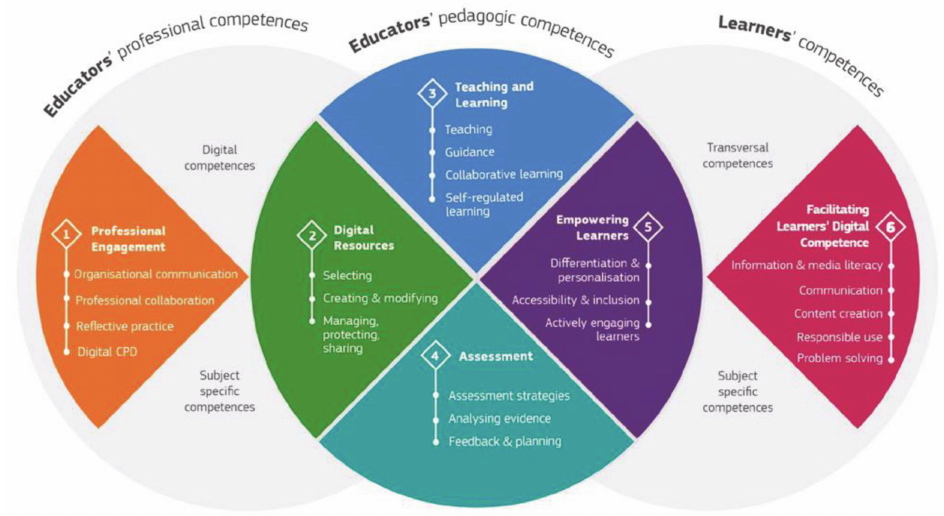
Figure 1. Conceptual view of the DigCompEdu framework